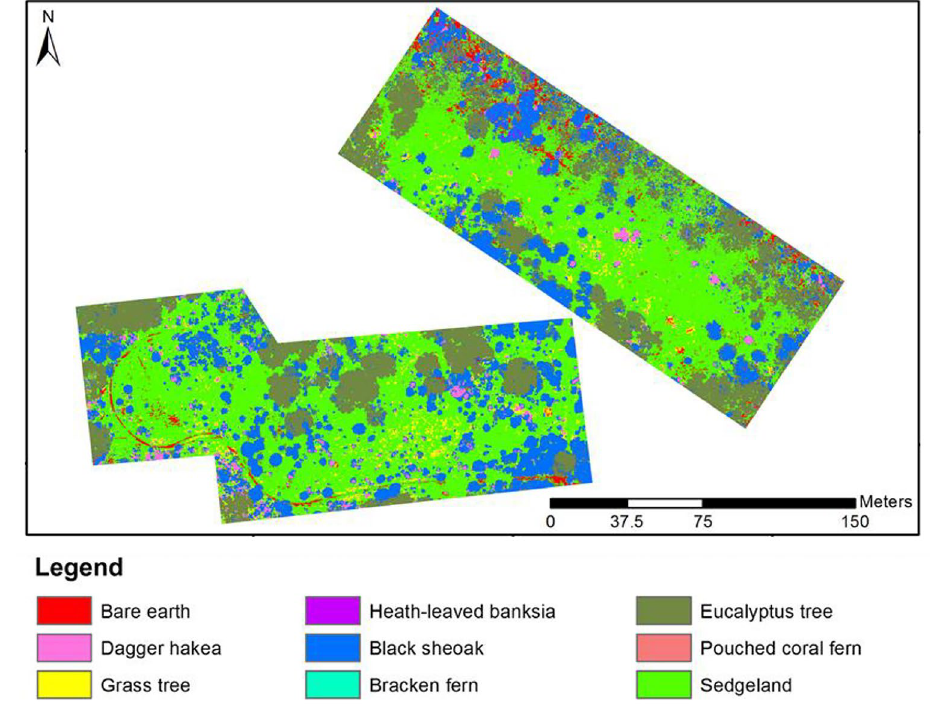
Fig. 8 Classification map of swamp site-1 and site-2 vegetation classes and species produced with a UAV-hyperspectral and b UAV-LiDAR data, using support vector machine